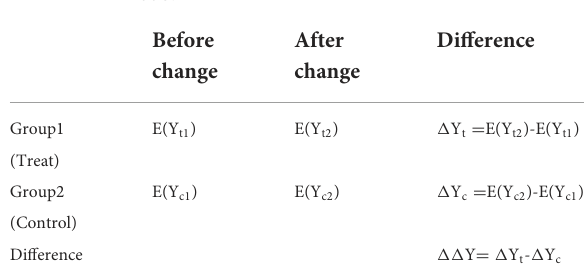
TABLE 1 DID model.